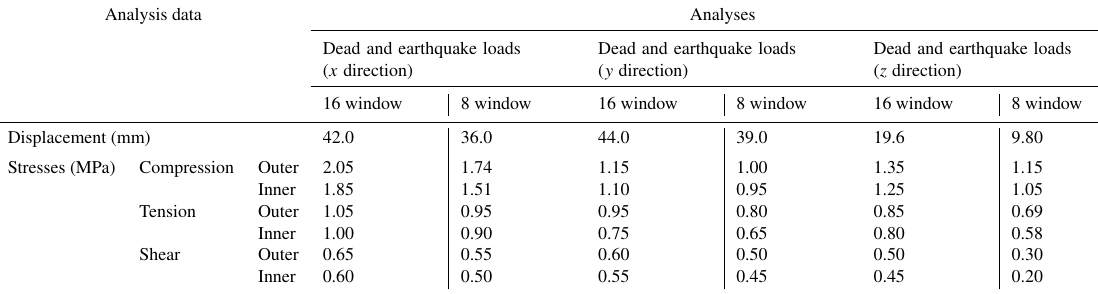
Figure 17. Finite element model of the mosque with eight window openings. Table 3. Complete analysis results of the mosque with 16 and 8 window